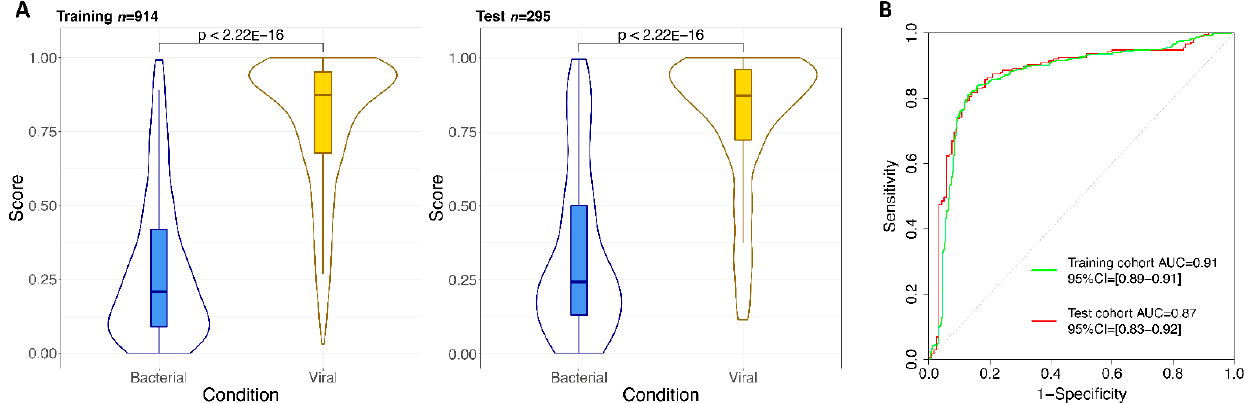
Figure 1. Signature performance based on the 14 genes in the training and test sets. ( A ) Violin and boxplots of the predicted values from the posterior mean. ( B ) Receiver operating characteristic (ROC) curves showing the area under the curve (AUC) and 95% confidence intervals (CIs).